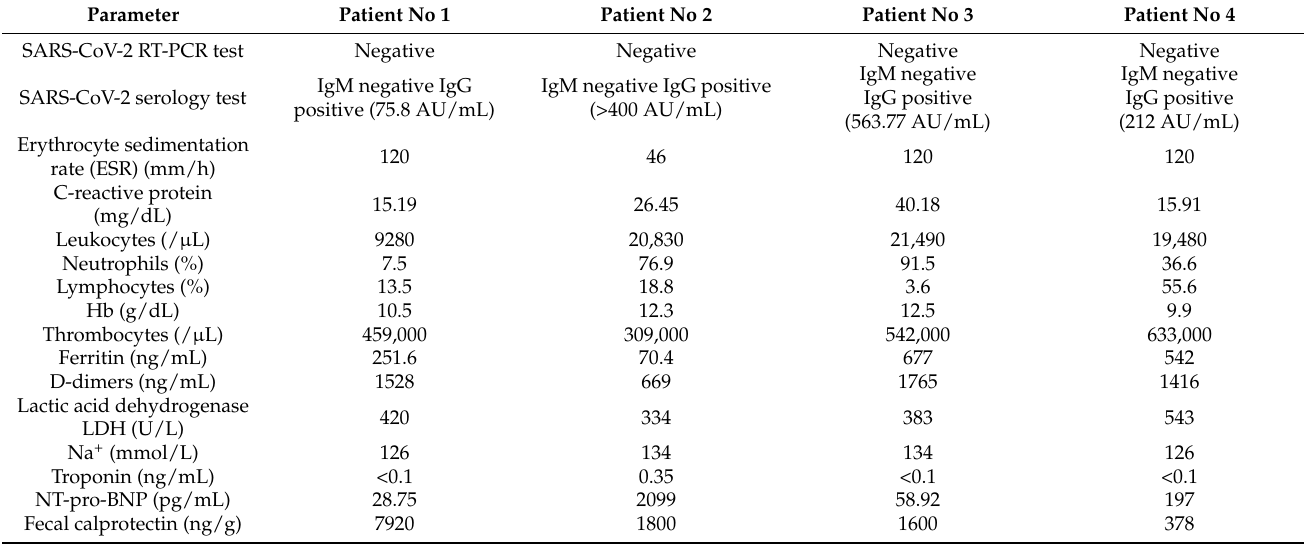
Table 2. Selected laboratory results at PIMS-TS/MIS-C